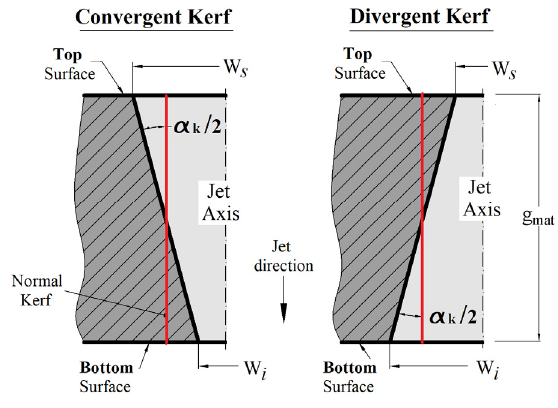
Figure 7. Kerf Tapering [11] Knowing the values of KW previously depicted, it was established KT and KTA using formulas given by the relation (5) and (6). Due to KT and KTA analytically related, graphical representation of both, depending on SOD have the same shape, excepting only the values of